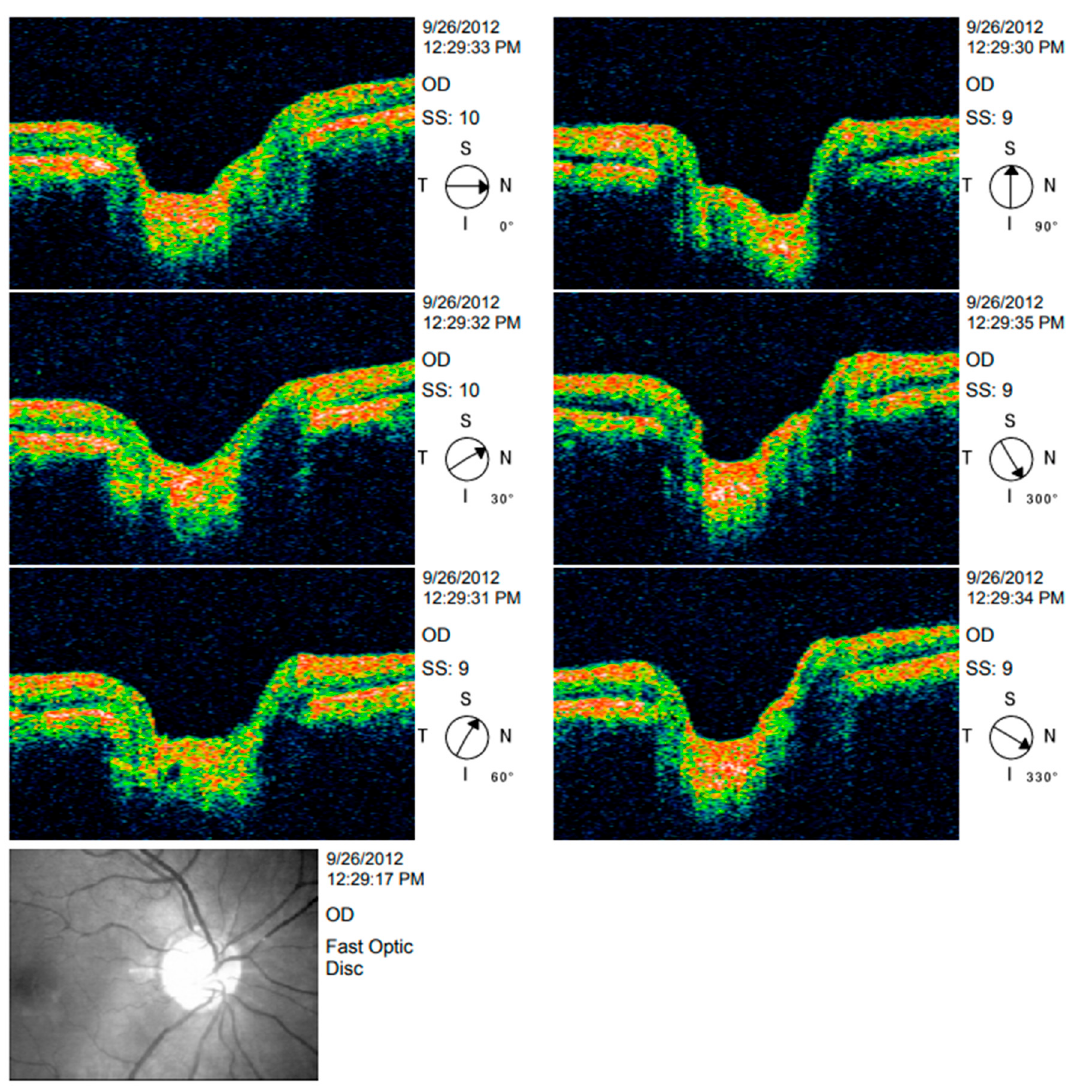
Figure 4. OCT image analysis. Table 2. The thickness of the retinal nerve fibre layer in various parts of the optic disc for 10 pa- tients is listed out.